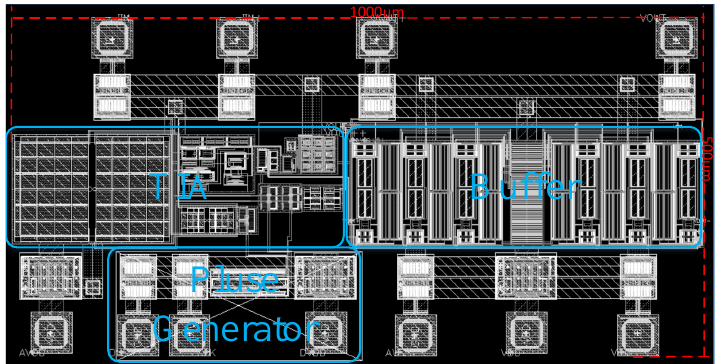
Figure 17. The layout of the TIA with